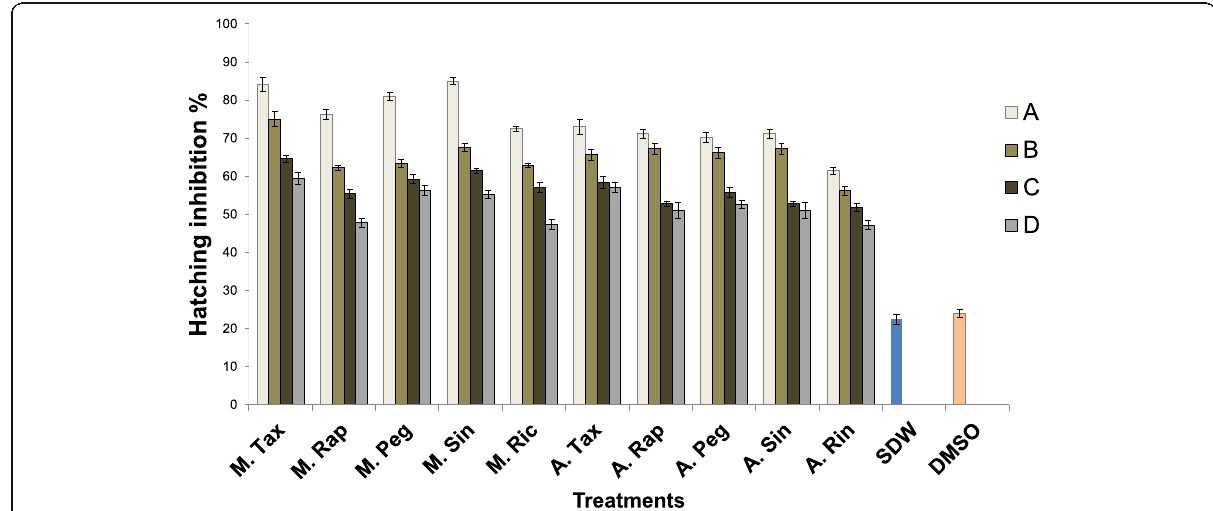
Fig. 4 Effect of plants extract at various exposure concentrations (A: 80%, B: 60%, C: 50% and D: 40%) on hatch of Meloidogyne incognita juveniles after 12-day incubation A: aqueous, M: methanolic, Tax: T.baccata, Peg.: P. harmala, Sin.: S. arvensis, Rap.: R. raphanistrum, Ric.: R. communis , SDW: sterile distilled water and DMSO: